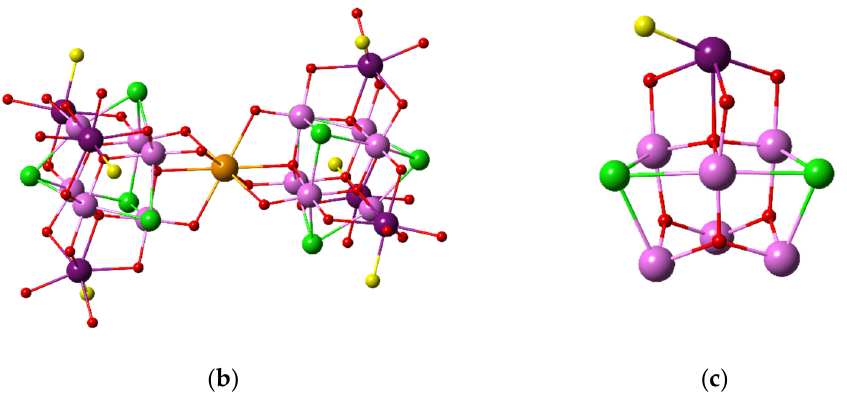
Figure 1. Single crystal X-ray structure of Mn 18 Sr . ( a ) Molecular structure of [Mn III12 Mn II6 Sr( μ 4 - O 8 )( μ 3 -Cl) 8 (HL Me ) 12 (MeCN) 6 ] 2+ ( Mn 18 Sr ). ( b ) Core structure of Mn 18 Sr in which the organic ligands have been omitted for clarity. ( c ) Detail of the cubane-like {Mn 7 Cl 2 O 7 } cluster containing a 7-coordinated ‘dangling’ Mn II atom in the {Mn III6 Mn II4 } core of Mn 18 Sr . Color code: Mn II (purple), Mn III (pink), Sr (orange), Cl (green), C (gray), O (red), N (blue) and H (white); solvent position in ( b , c ) are shown as yellow spheres.